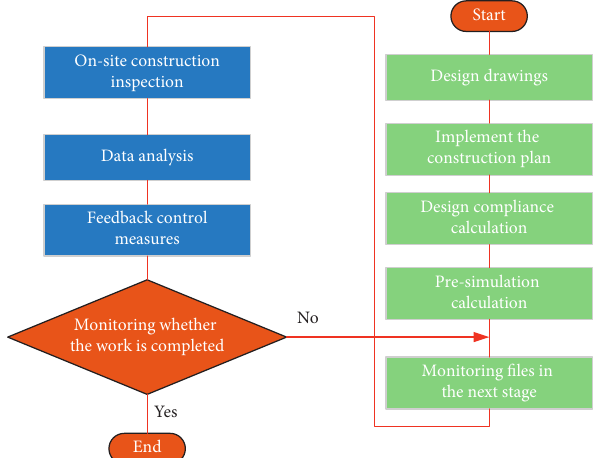
Figure 8: Schematic diagram of the monitoring process of prefabricated building construction.